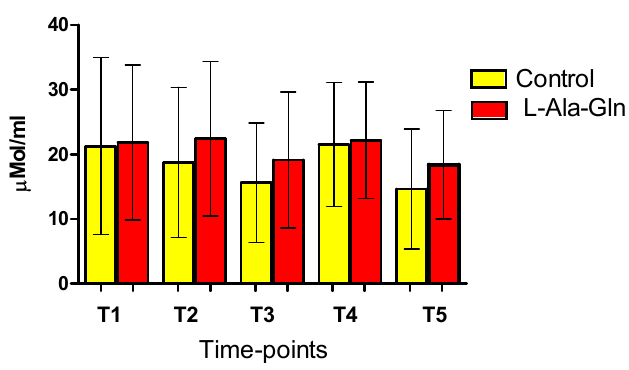
FIGURE 4 - Reduced glutathione (GSH) concentrations (micromoles of GSH per ml of plasma) in saline (control) and L-Ala-Gln-treated patients. Bars represent mean ± SD of control (yellow bars) and L-Ala-Gln (red bars) groups during different time-points. Groups studied are not significantly different by ANOVA test (Tukey).